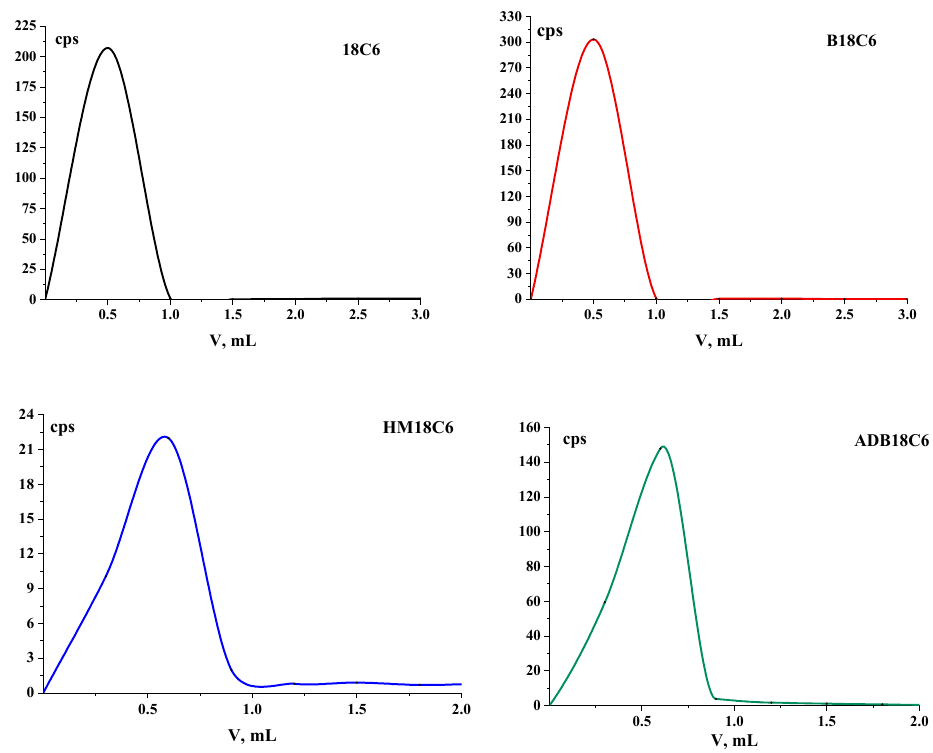
Figure 2. Elution curves of the studied LCEs on columns with Al 2 O 3.